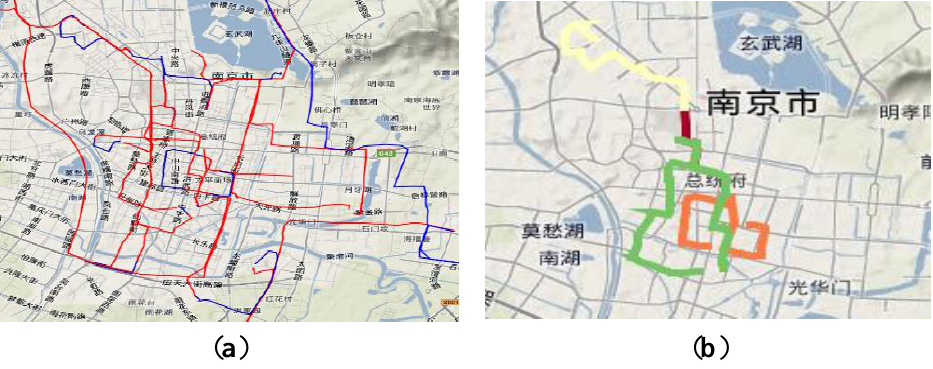
Figure 6. ( a ) Forty-five original trajectories; ( b ) four sub trajectory sets after clustering ( t = 0.8